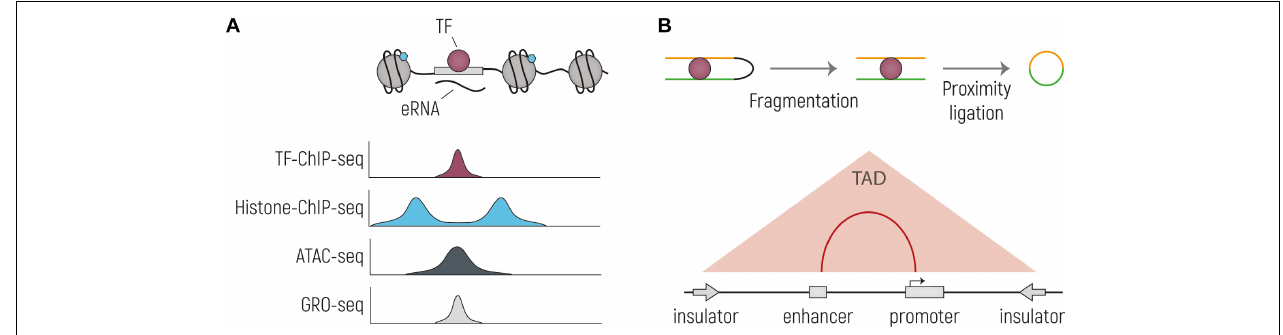
FIGURE 2 | Overview of the main techniques currently used to identify putative enhancer sequences and their interacting genes. (A) Schematic drawing of an TF-bound enhancer, located in nucleosome depleted DNA from which eRNA is transcribed. Below are representative genome browser tracks shown, illustrating expected profiles for the same genetic region. Histone-ChIP-seq is illustrative for marks such as H3K27ac and H3K4me1. (B) Cartoon representing the main steps of the workflow of Chromosome conformation capture technologies: nuclei are cross-linked, chromatin is then digested and re-ligated by proximity ligation. The two stretches of DNA that are normally located far away from each other (yellow and green), are now ligated together and can be tested by PCR or sequencing. In the bottom part is indicated the output of the experiment, with which TADs and enhancer-promoter interactions can be identified.